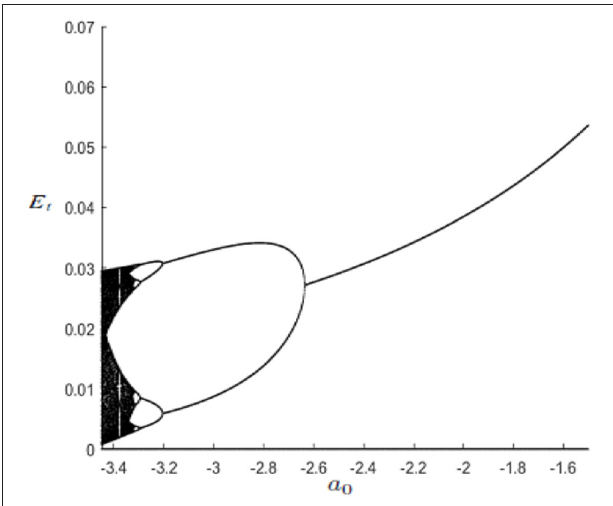
FIGURE 2 | Occurrence of a period-doubling sequence as a 0